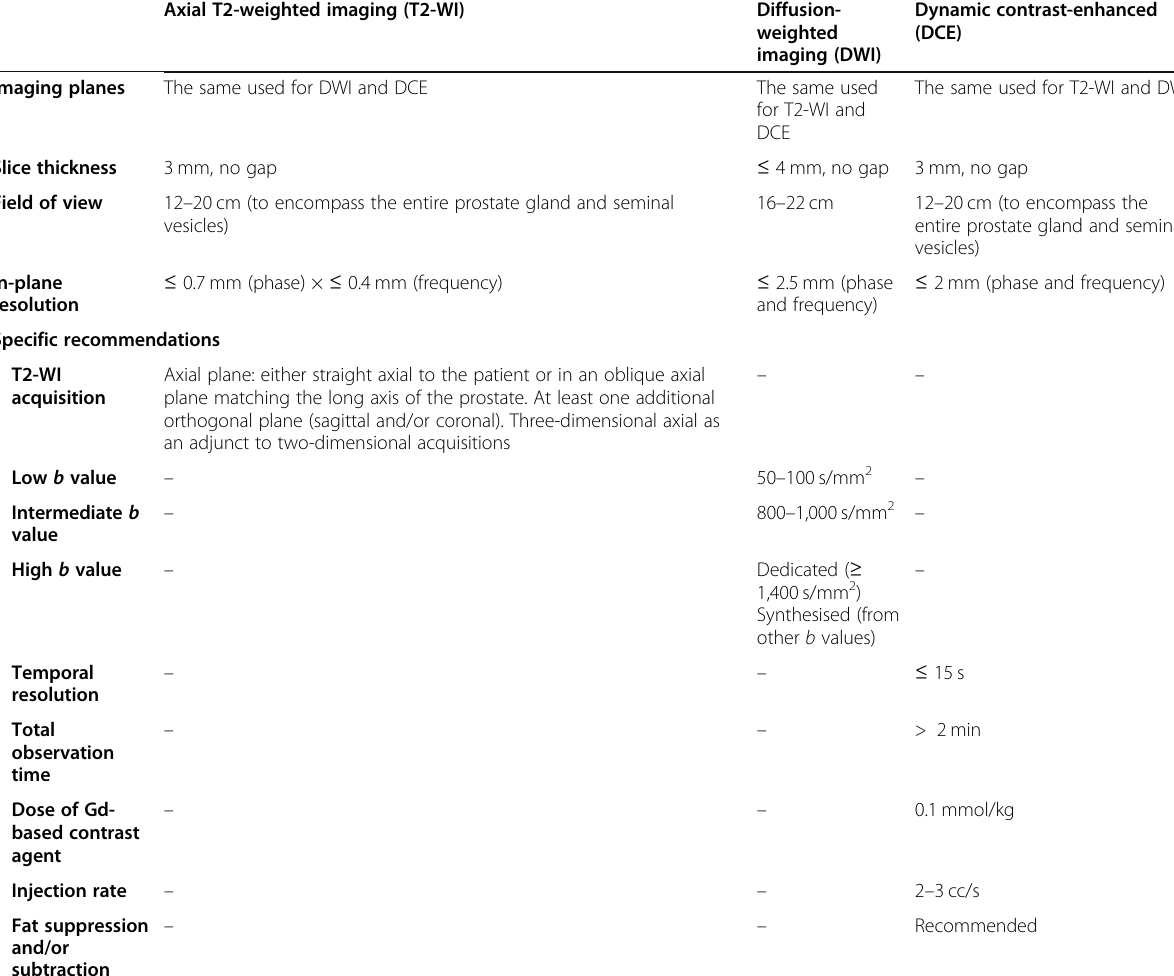
Table 1 Minimal technical requirements for multiparametric prostate MRI according to the PI-RADS v. 2.1 guidelines Axial T2-weighted imaging